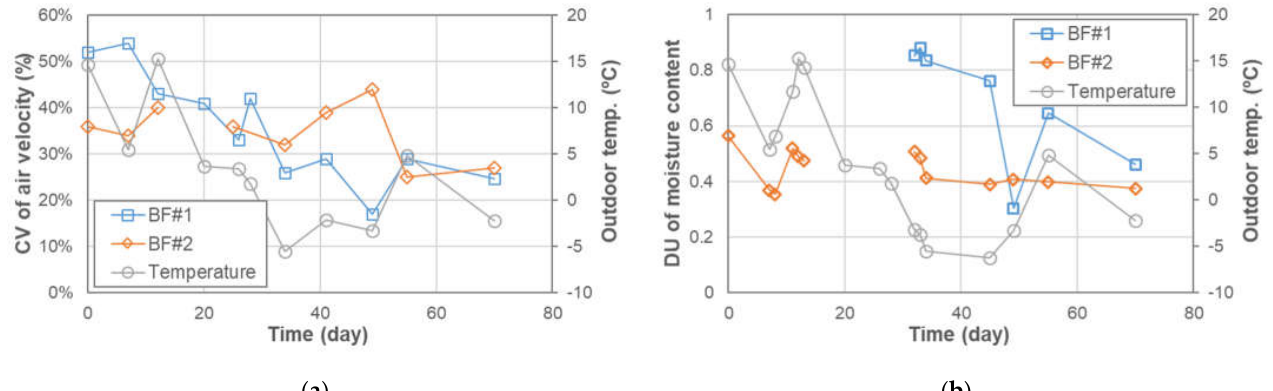
Figure 5. Temporal changes in the uniformity of ( a ) air velocity distribution and ( b ) woodchip moisture content. Note: A smaller CV value represents a more uniform distribution which a smaller DU value represents a less uniform distribution.